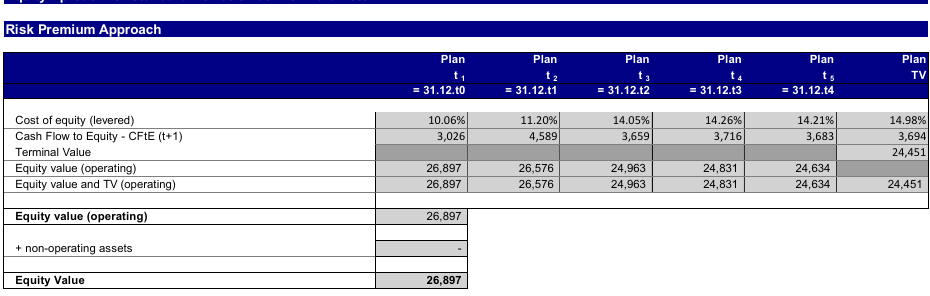
Figure 11. Calculation of the company value with the risk premium method.